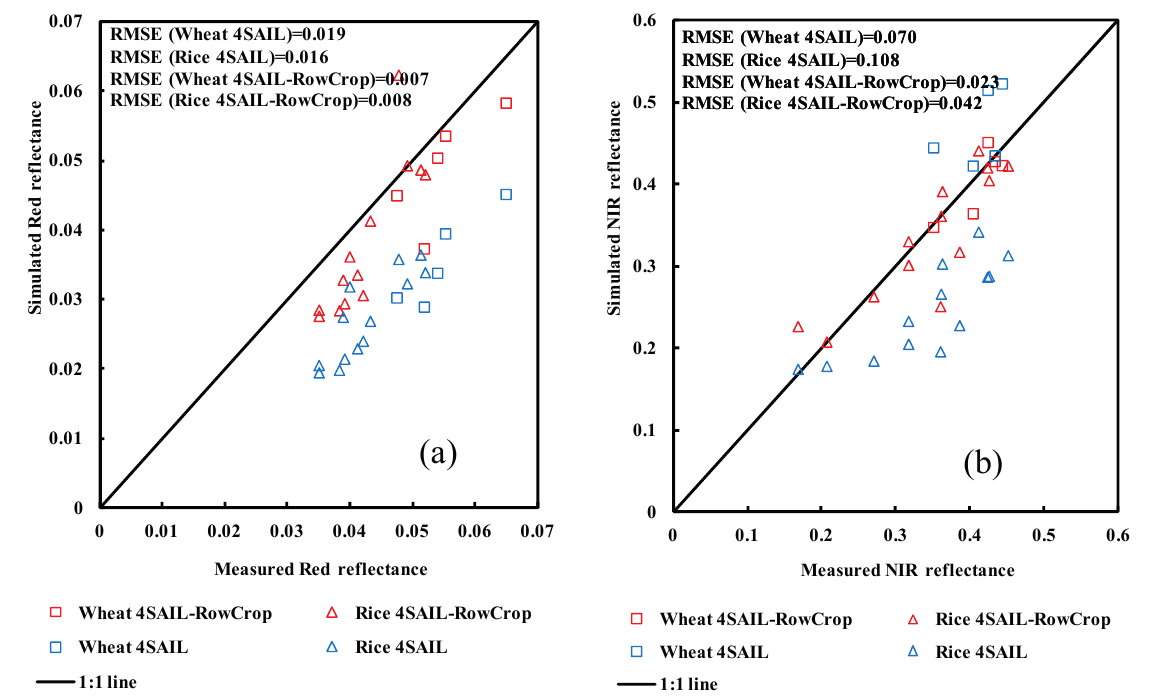
Figure 7. Measured versus simulated wheat and rice red reflectance values ( a ) and NIR reflectance values ( b ) of the 4SAIL-RowCrop model in the principal plane.